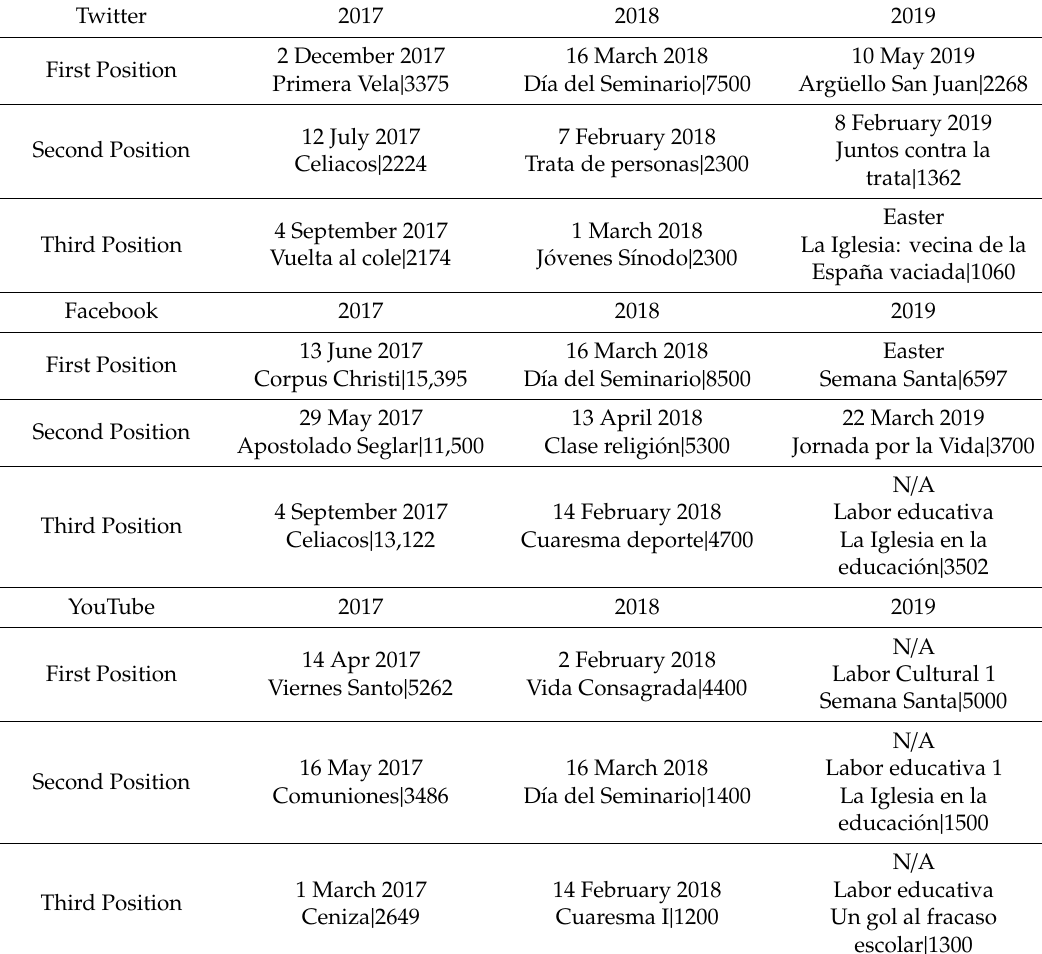
Table 6. CEE’s most popular videos on Twitter, Facebook, and Youtube